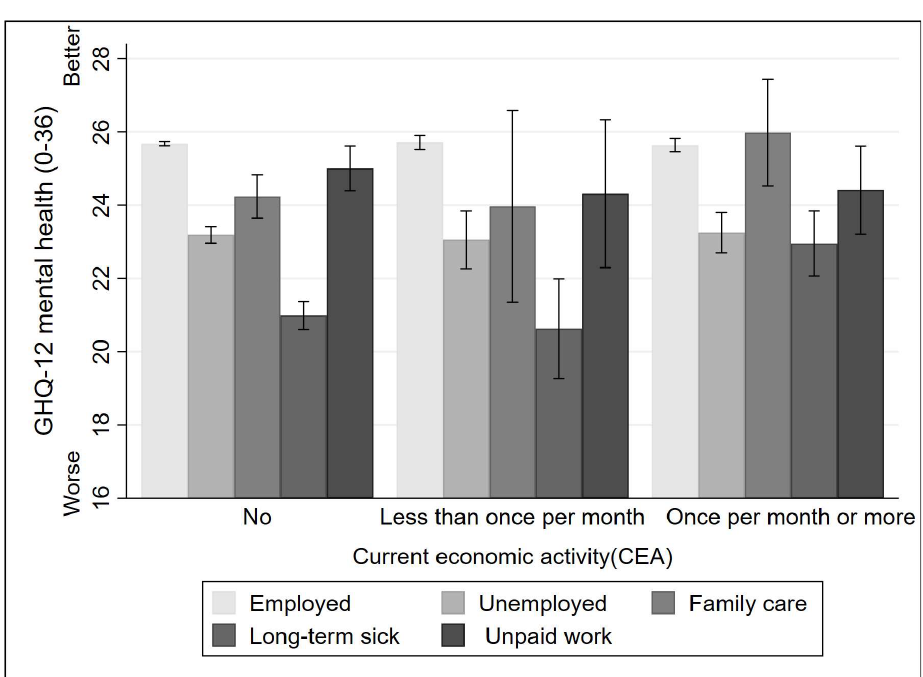
Figure 1. Differences in mental health between volunteering frequency distinguish current economic activity (Men).